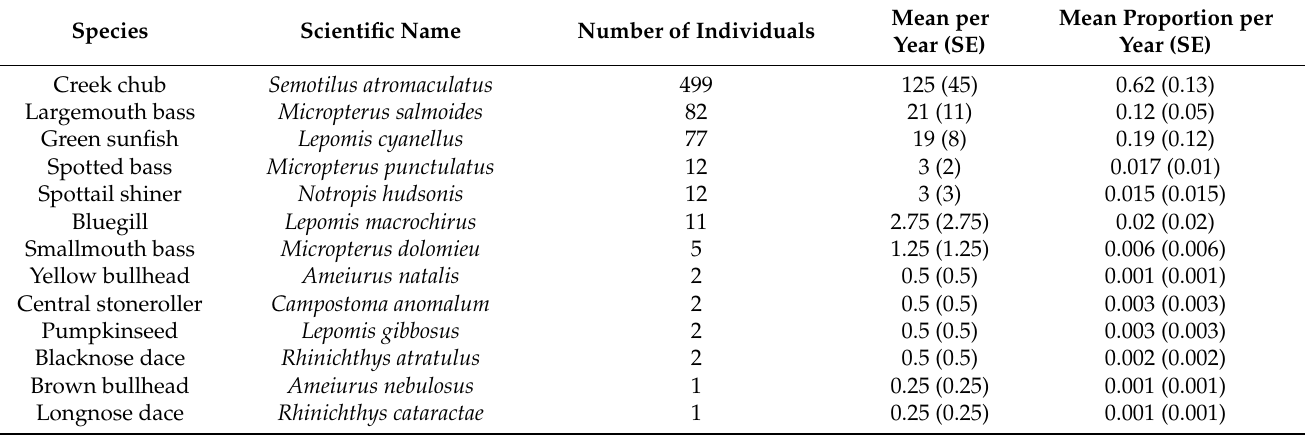
Table 7. Species assemblage of fishes surveyed by single-pass electroshocking in Ruby Run at JW Ruby Research Farm in Preston County, West Virginia, USA, from 2017 to